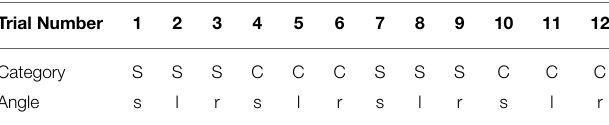
TABLE 1 | Pseudo-random item categories and WBB angles in the 12 trials.